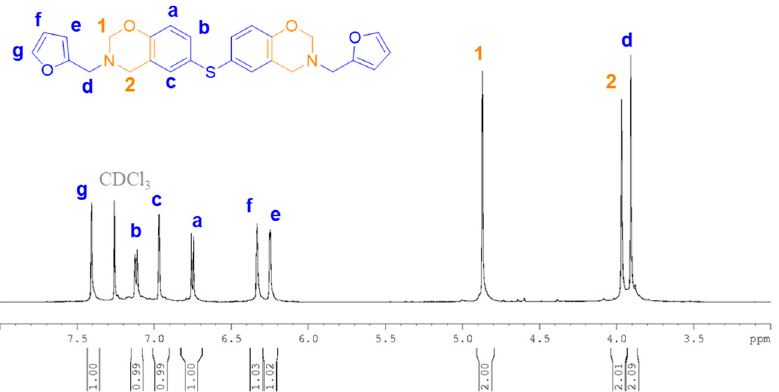
Figure A12. 1 H NMR spectrum in CDCl 3 of 4DTP-fa.